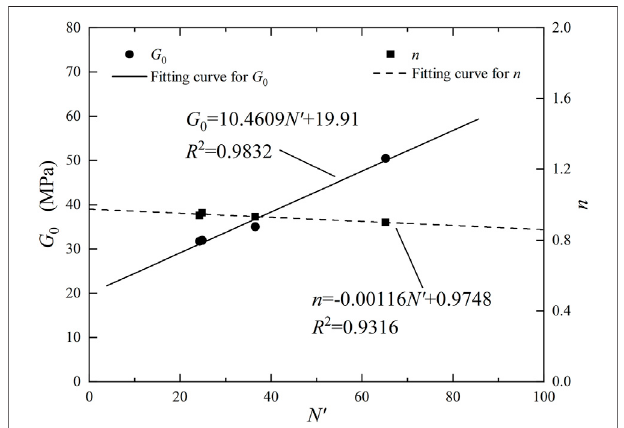
FIGURE 11 | Relationship of N ′ , σ ′ m and G max for weathered granite in the Lincang